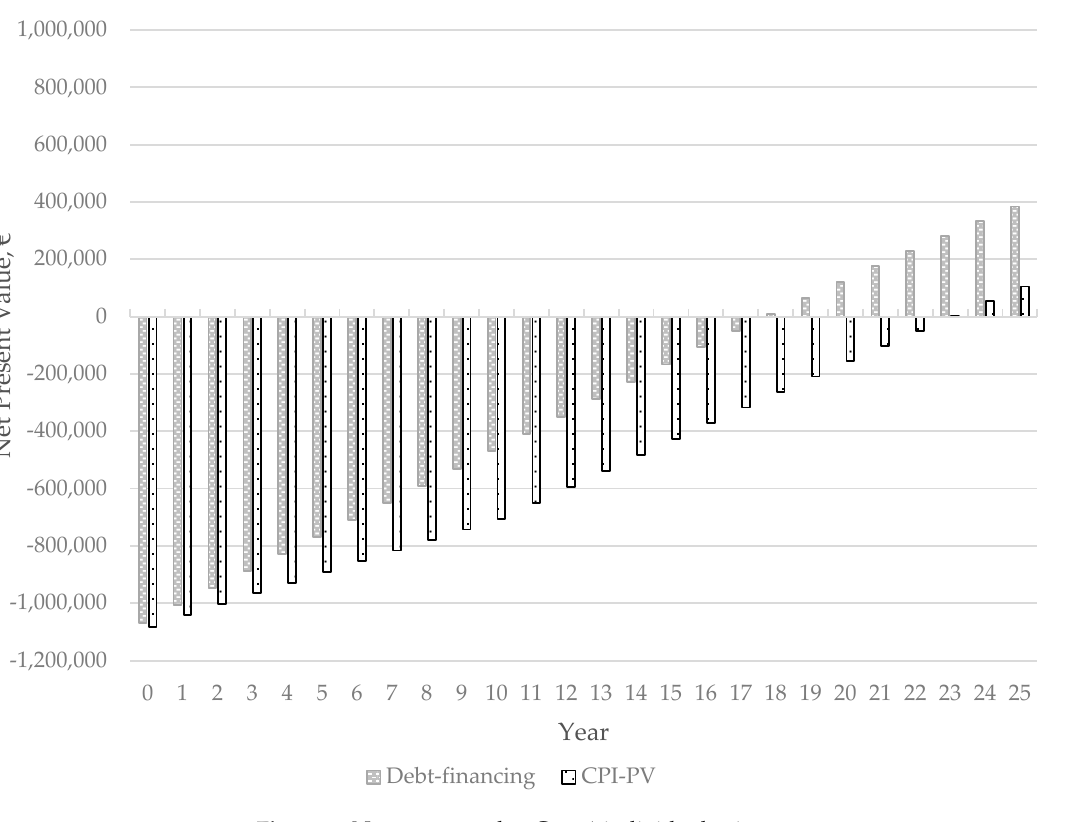
Figure 2. Net present value Case 1 individual prices.